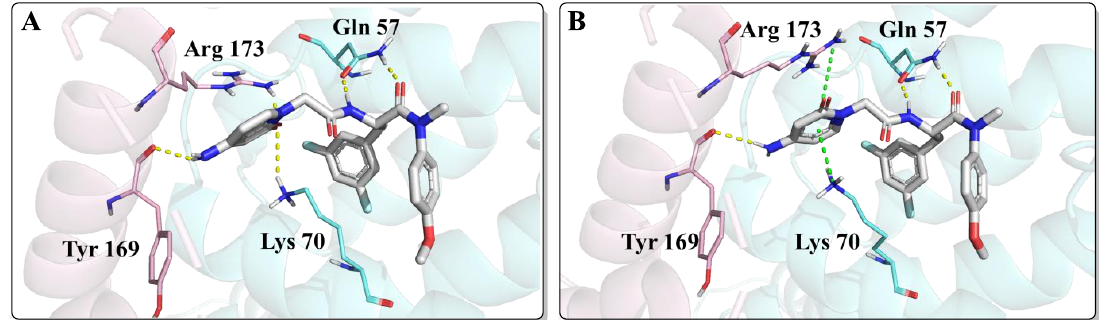
Figure 4. The two highest populated binding modes of FTC-2 within the CTD-NTD interprotomer pocket of HIV-1 CA. ( A ) The binding mode when the carbonyl group of 2-pyridone faced the inside of the binding pocket. ( B ) The binding mode when the carbonyl group of 2-pyridone faced the outside of the binding pocket. The two HIV-1 CA protomers are highlighted in cyan and pink. Cation- π interactions are shown in green dotted lines and hydrogen bonds in yellow dotted lines.